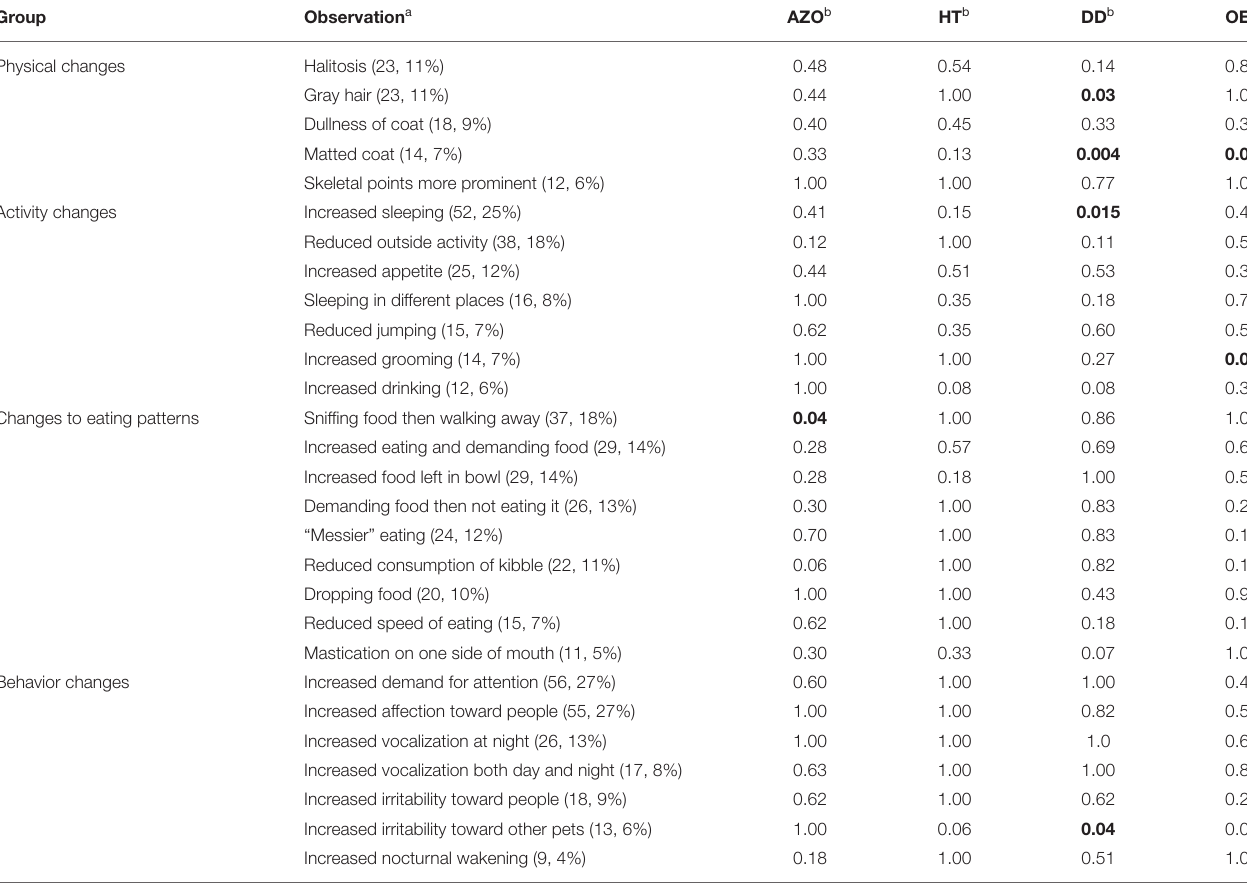
TABLE 4 | Significance of owner observations and associations with health status on enrolment in 206 cats aged 7–10 y. Group